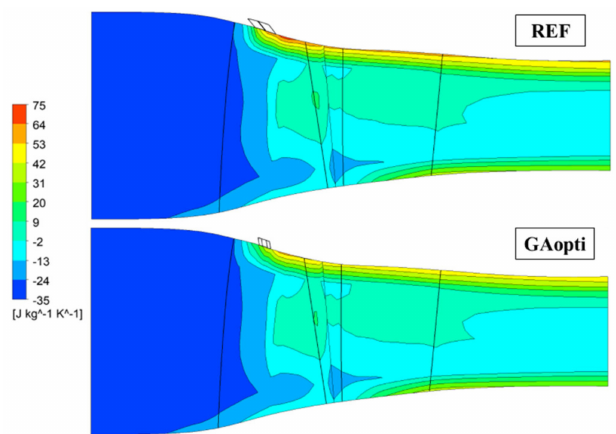
Figure 17. Circumferentially averaged static entropy distribution at peak adiabatic efficiency